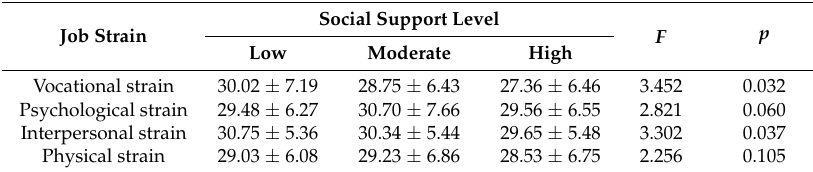
Table 4. Association between social support level and job strain subscales.